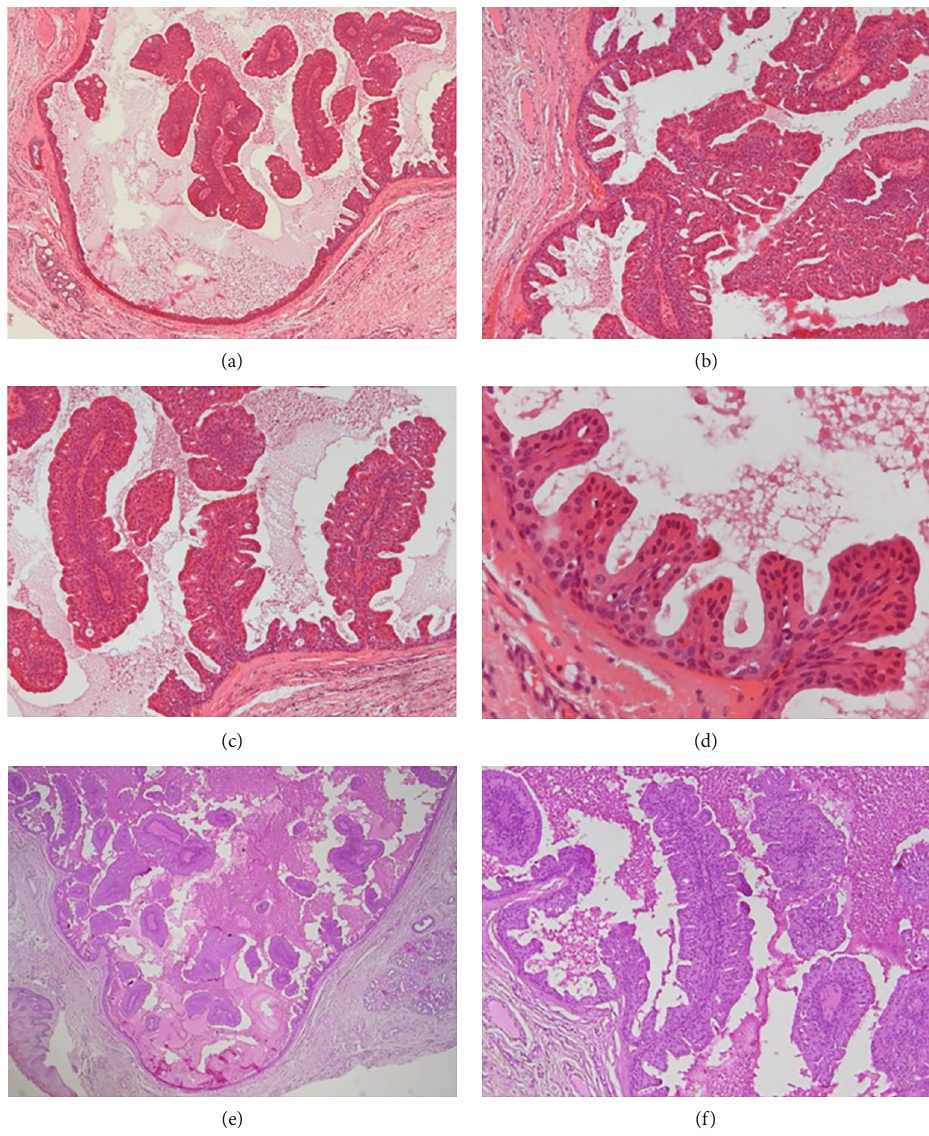
Figure 1: Histopathological section of the oral intraductal papilloma. (a) The cystic cavity fi lled by papillary tumor projections and anastomosing proliferations of columnar epithelial cells in a fi brovascular core (haematoxylin and eosin stain, H&E, original magni fi cation × 5). (b – d) Note that the cystic wall is lined by uniform layers of cuboidal/columnar oncocytic epithelial cells, with no nuclear atypia or mitotic fi gures (H&E, original magni fi cation × 10 (b), × 20 (c), × 40 (d)). (e, f) Note the mucous cells showing positivity for periodic acid- Schi ff , presence of mucous material in the lumen and minor salivary gland acini in fi brous tissue (P.A.S., × 5 (e), × 20